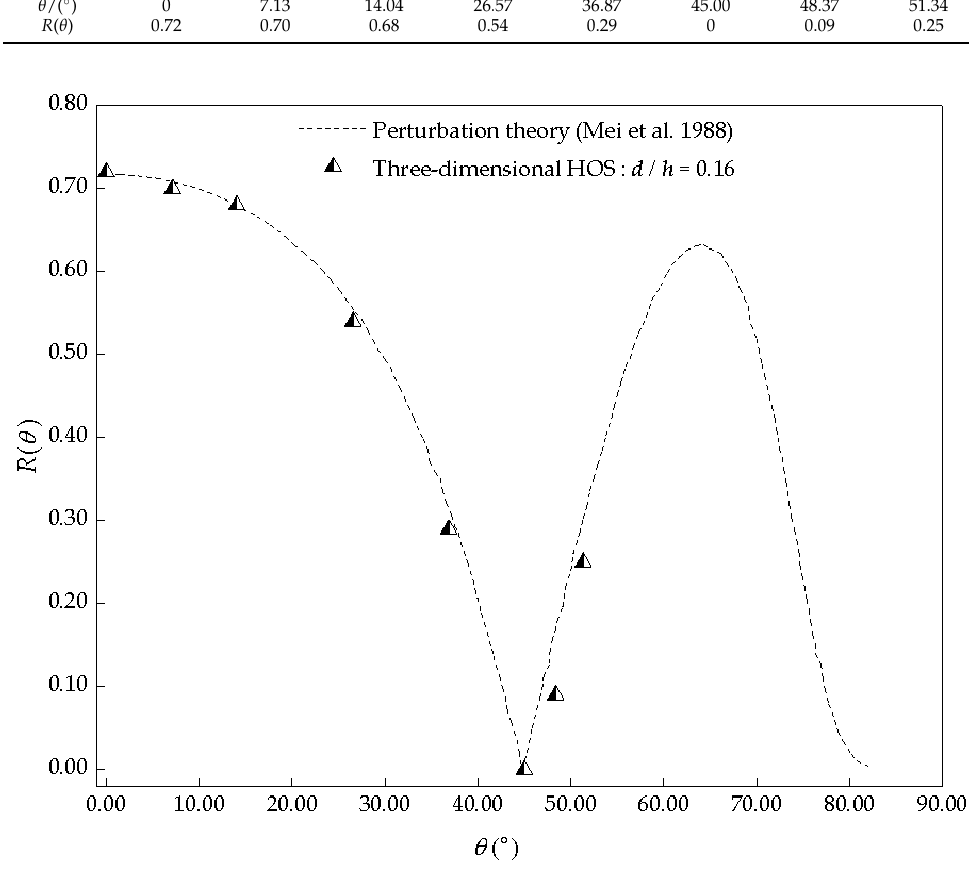
Fi gure 2. Reflection coefficients R ( θ ) comparisons of Class I Bragg resonance. Figure 2. Reflection coefficients R ( θ ) comparisons of Class I Bragg